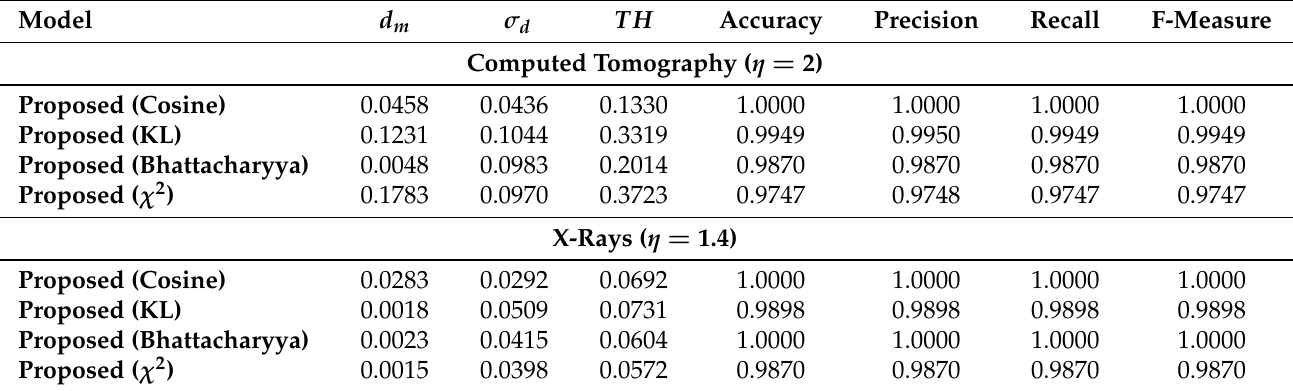
Table 5. Results obtained by the proposed approach under the two considered datasets. The results have been obtained by using N T = 500 reference images from the N class and a number N bin = 50 of histogram bins.